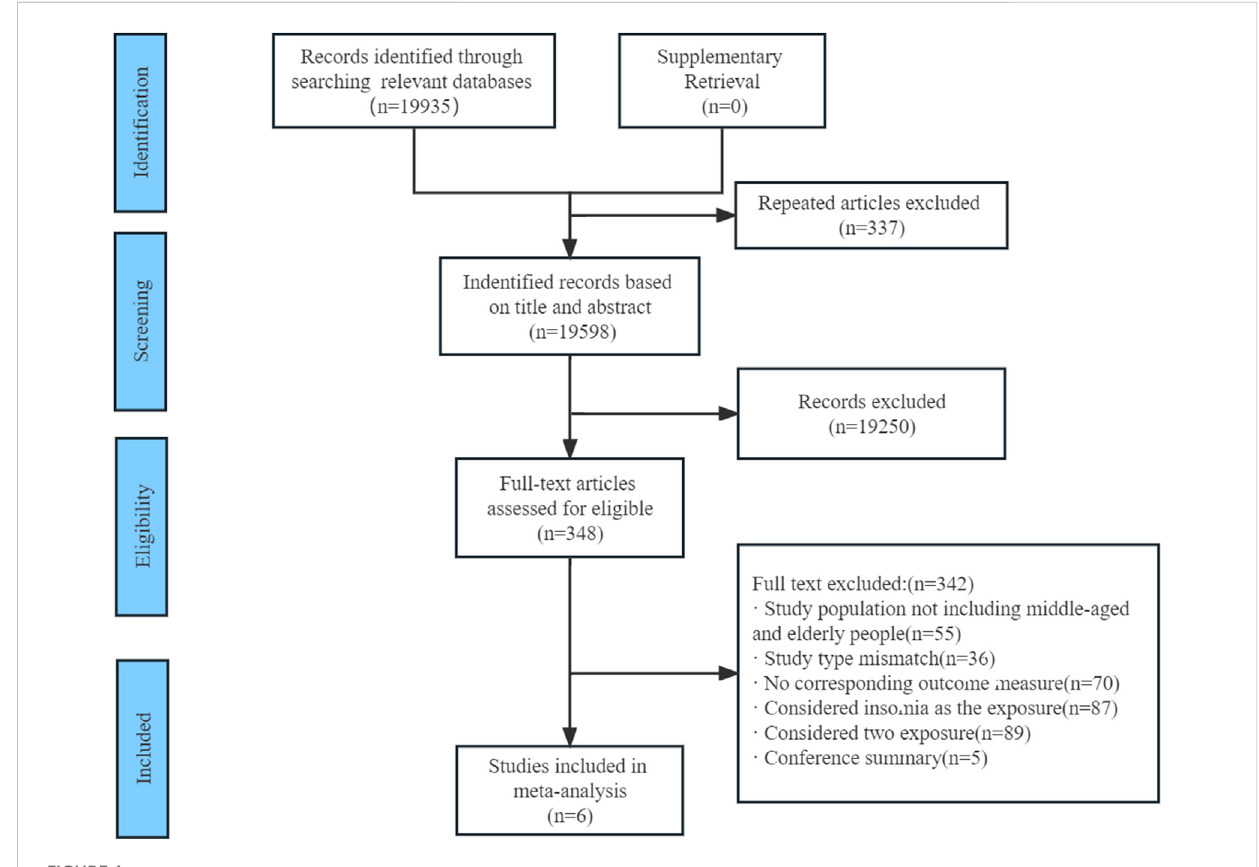
FIGURE 1 Flow diagram of the search strategy and study